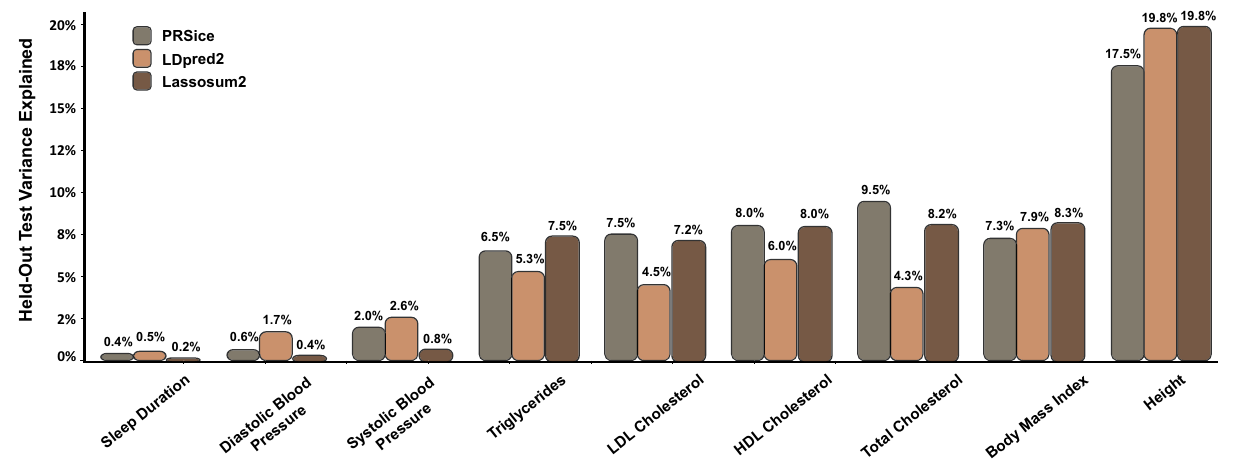
Fig. 1 PRSice, LDpred2, and Lassosum2 Linear PRS results. Best-performing PRSice (gray) compared to best-performing LDpred2 (orange) and best Lassosum2 (brown) across the hyperparameters tuned using the training data.